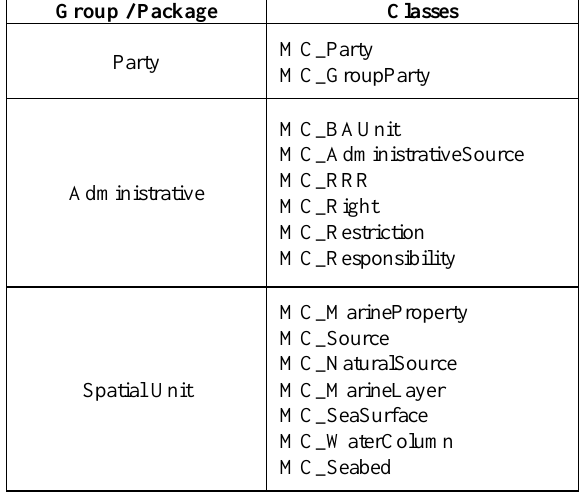
Table 1. 3D Marine Cadastre Data Model possible